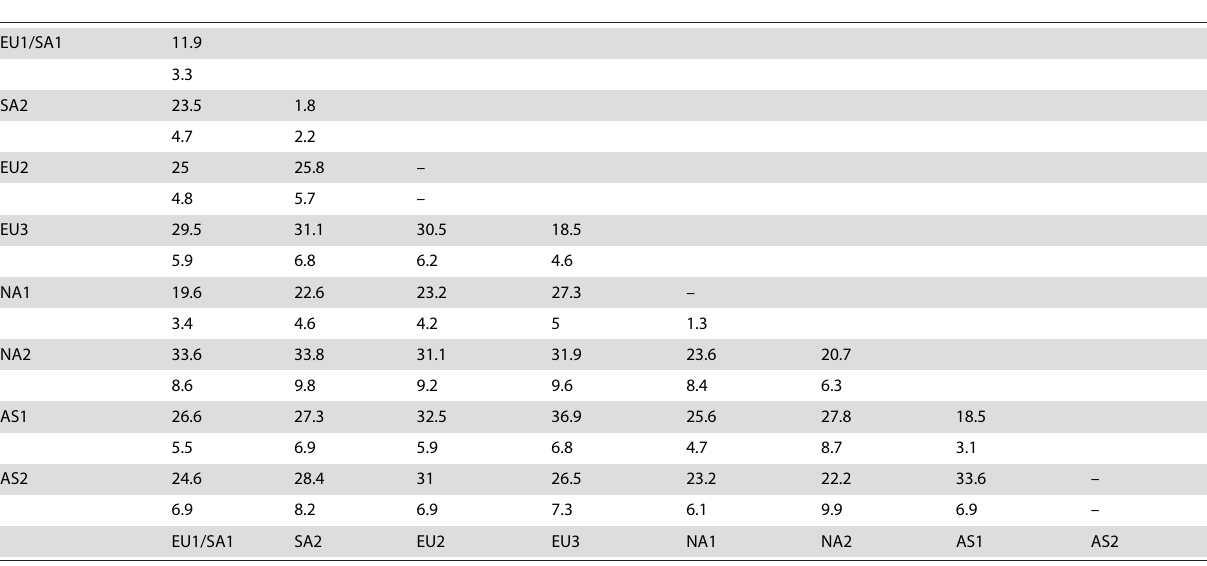
The upper values represent the divergence for Fsp; the lower values represent the divergence for the H protein. AS1, Asia 1; AS2, Asia 2; EU1/SA1, Europe 1/South America 1; EU2, Europe 2; EU3, Europe 3; NA1, North America 1; NA2, North America 2; SA2, South America 2.